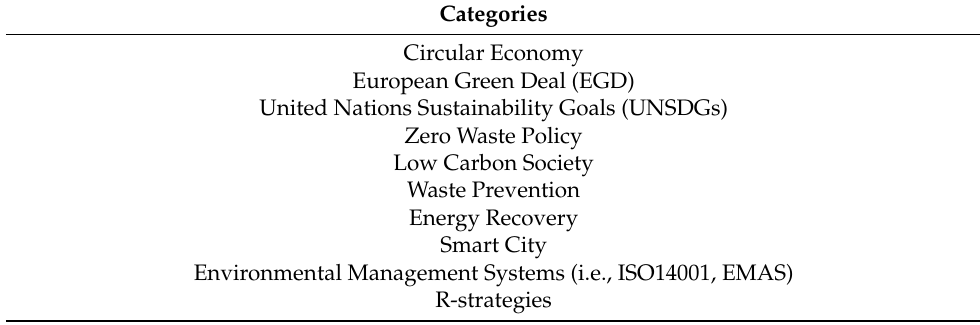
Table 12. Strategies for